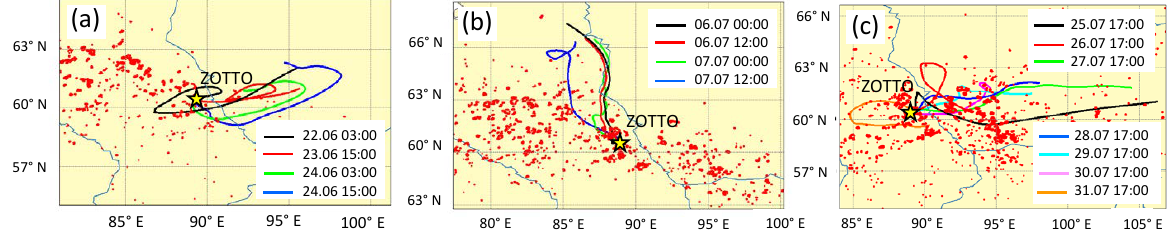
Figure 7. Figure shows 72h HYSPLIT air mass trajectories during summer biomass burning events at ZOTTO at 300m: 22 to 24 June 2012 (a) , 6 to 7 July 2012 (b) , and 25 to 31 July 2012 (c) . Red dots indicate the fire